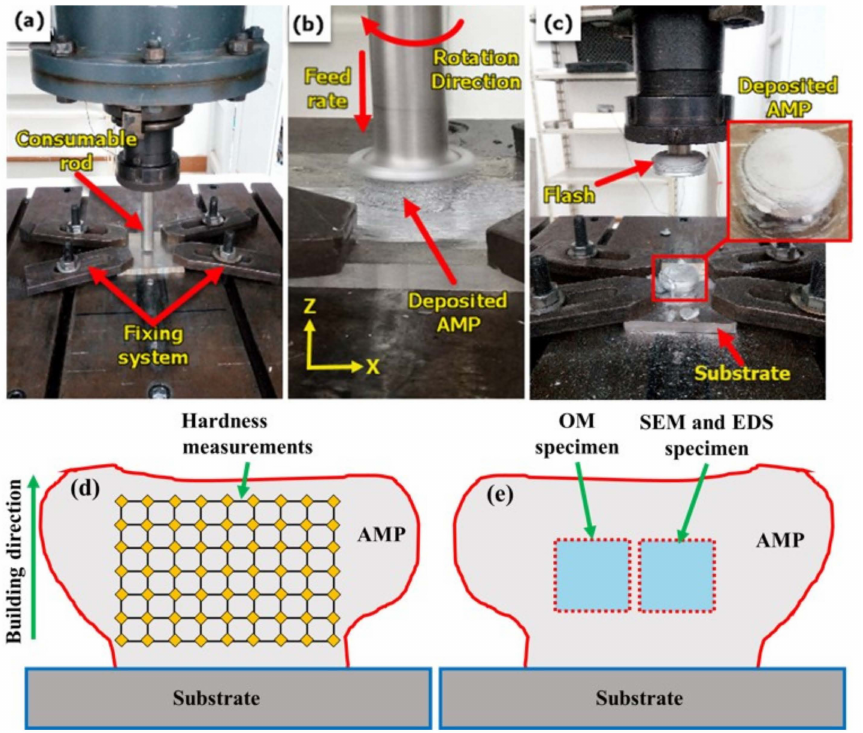
Figure 2. Photographs for the stages of the FSD process: ( a ) Fixing the AA2011 consumable rod and substrate AA5083 on the FSW/FSP machine, ( b ) feeding process during the FSD showing the building up of the part, and ( c ) the end of the deposition process for the additive manufacturing part (AMP). ( d ) and ( e ) are schematic drawings of the AMP sections showing hardness measurement points, and the second half of AMP shows the specimens cut for OM and SEM examinations,